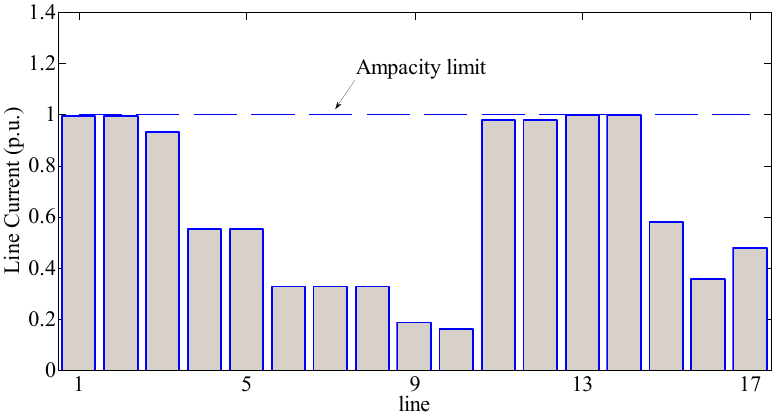
Figure 8. Case Study 2: Line currents of the residential feeder (phase no.1) at hour 21.00 of the last typical day.